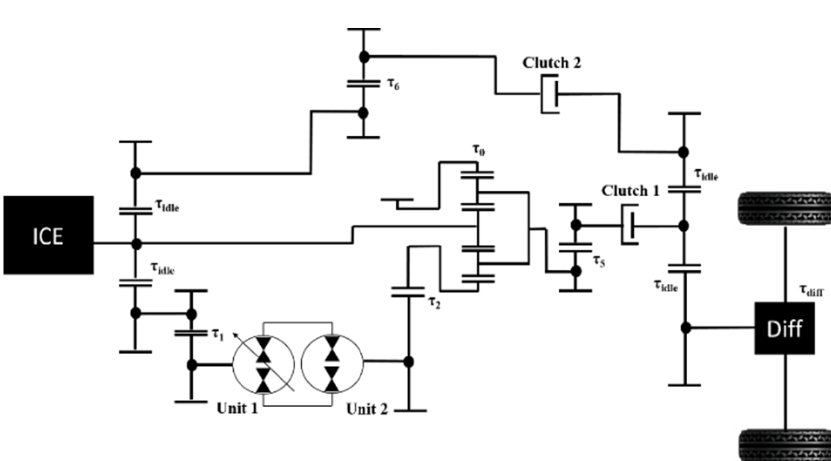
Figure 4. Scheme of hydrostatic transmission.